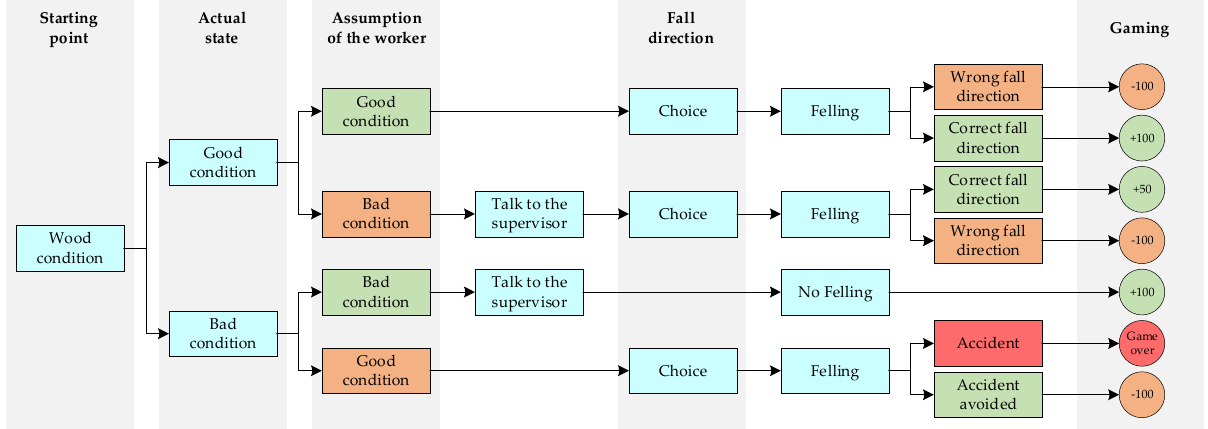
Figure 17. Situation tree representing a simplified case of a feller with the score associated with the gamification layer.